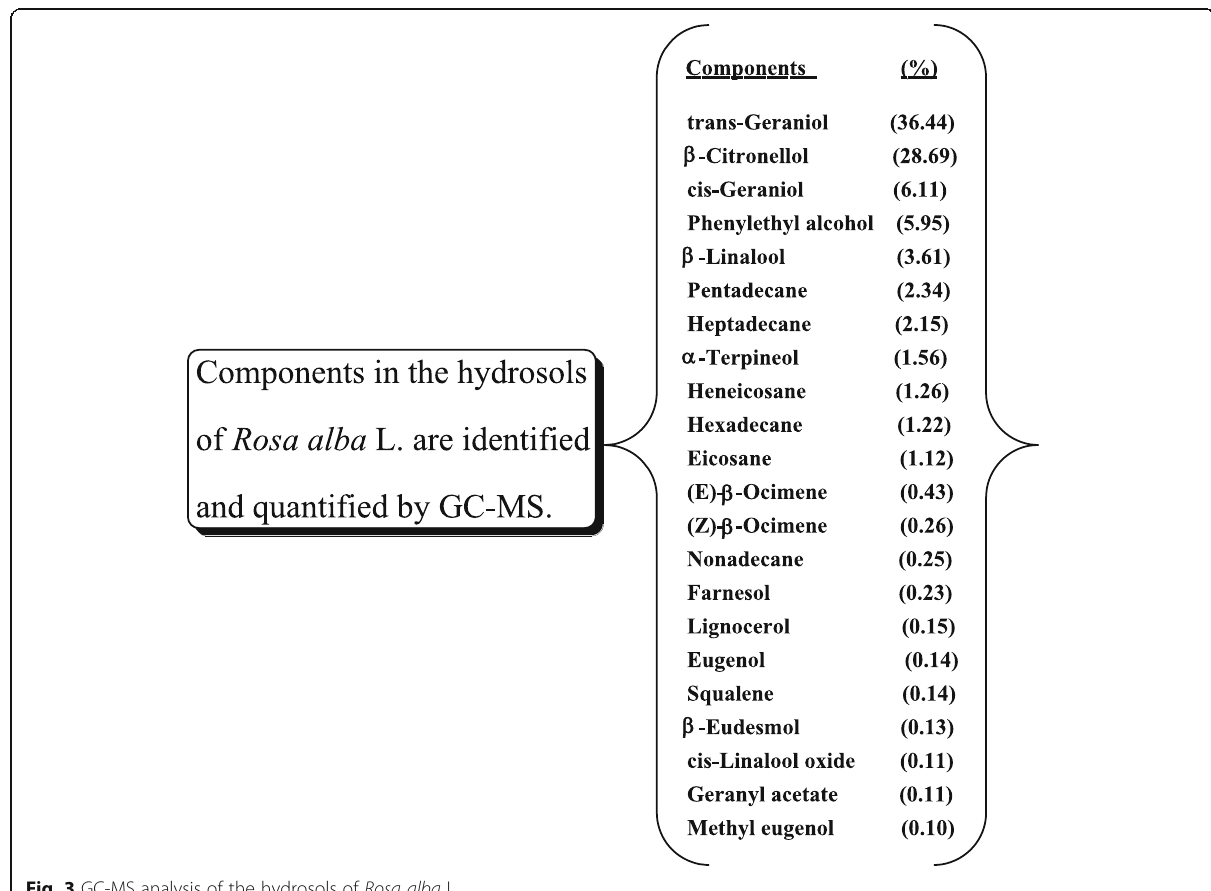
Fig. 3 GC-MS analysis of the hydrosols of Rosa alba